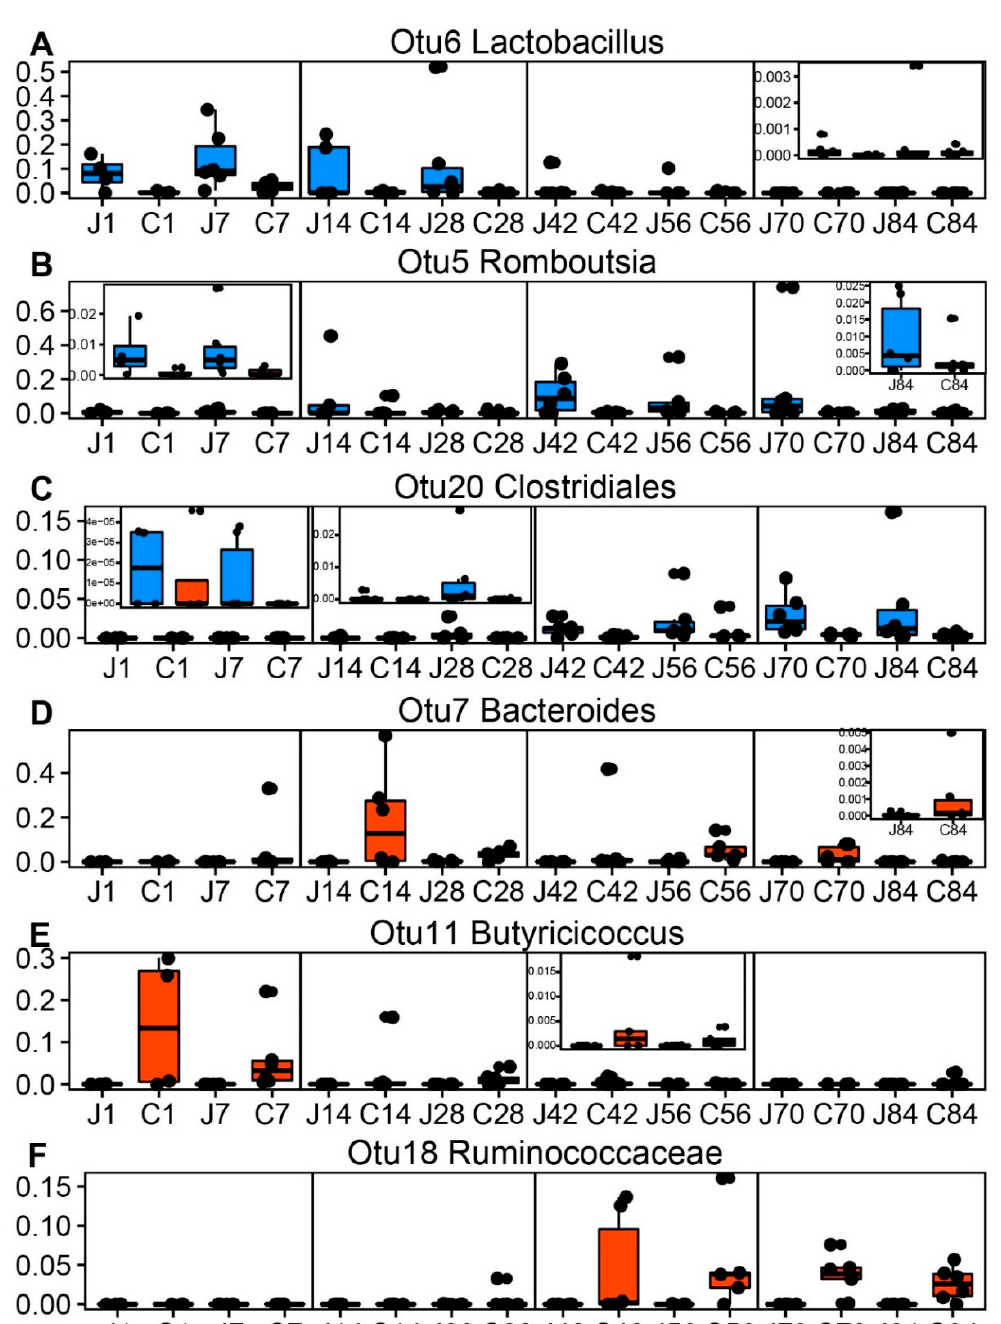
Figure 7. The boxplots of representative bacteria identified by LEfSe to display the microbial di ff erences of the biogeography. The shared OTUs between the jejunum and colon including ( A ) Lactobacillus (OTU6), ( B ) Romboutsia (OTU5), ( C ) Clostridiales (OTU20), ( D ) Bacteroides (OTU7), ( E ) Butyricicoccus (OTU11) and ( F ) Ruminococcaceae (OTU18) represented the biogeographic di ff erences. The dodgerblue and orangered colors represent the jejunum and colon, respectively. J1 = jejunum d1; C1 = colon d1; the rest can be deduced by analogy.